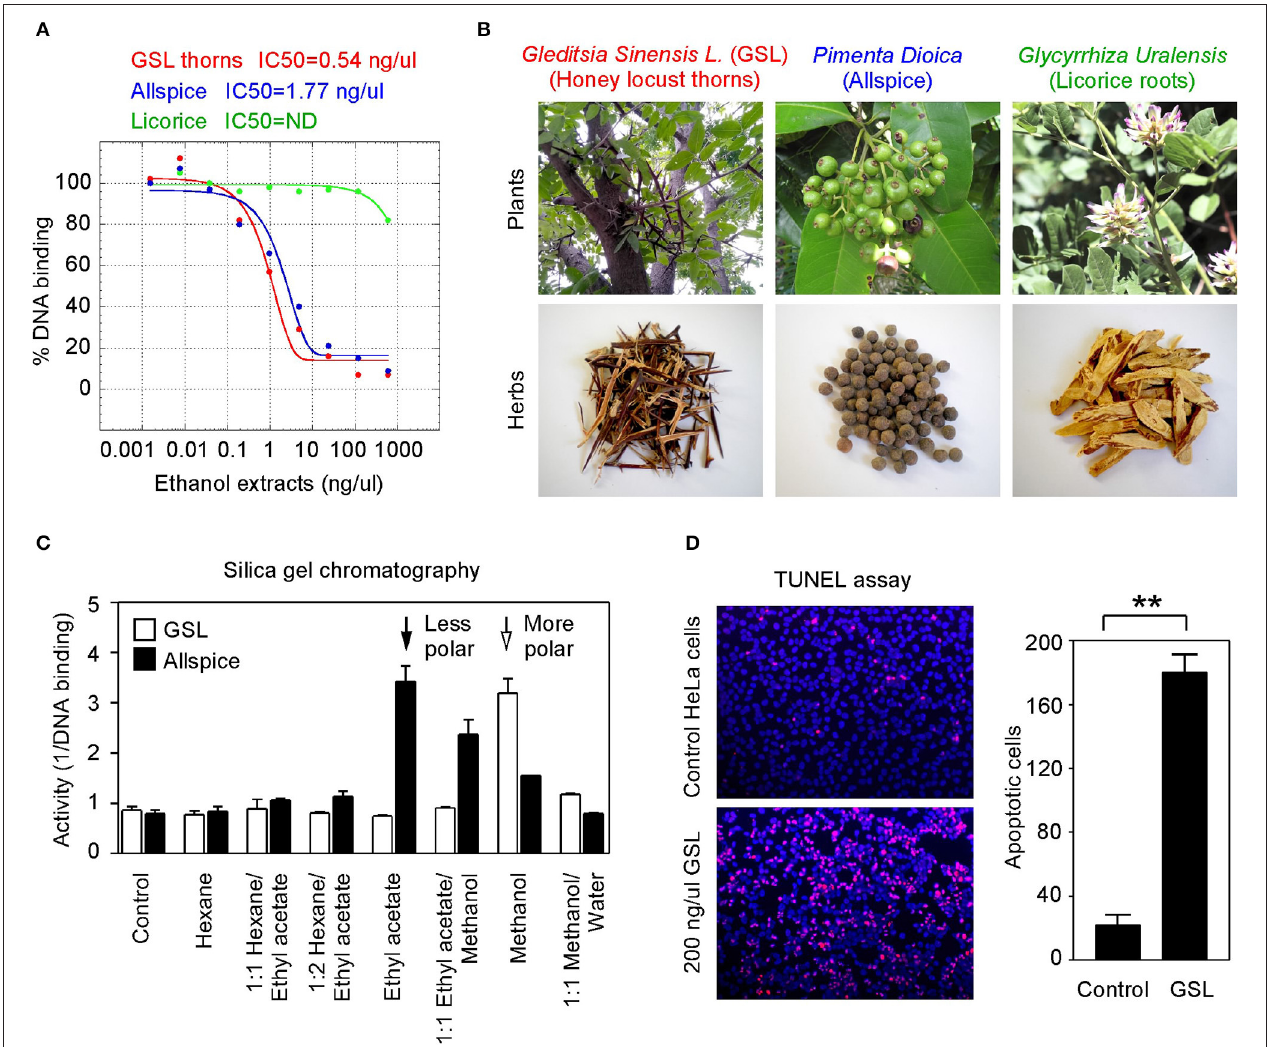
FIGURE 5 | Anticancer herbs inhibit GT198. (A) The thorn needles of GSL and berries of allspice extracts inhibit the DNA-binding activity of GT198. Licorice is a negative control. IC 50 s are as indicated. (B) Photographs of the plants and their corresponding herbs used in panel A. (C) Silica gel chromatography of GSL and allspice. Arrows indicate their most active constituents with different polarities when eluted from nonpolar to polar solvents. (D) TUNEL assay for apoptotic activity of GSL in HeLa cells. Quantitative representation of positive cell numbers in microscopic views is shown on the right. ** P <